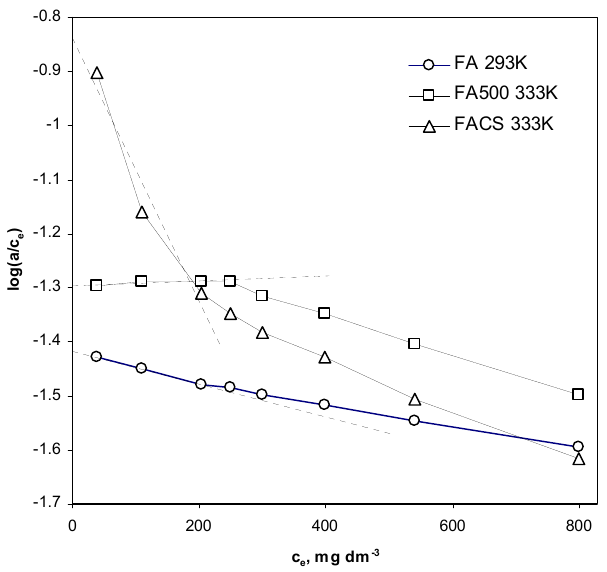
Figure 11. Khan and Sing plots for selected adsorbents studied in this paper. The dashed lines are linear fits for adsorption points at three lowest concentrations.